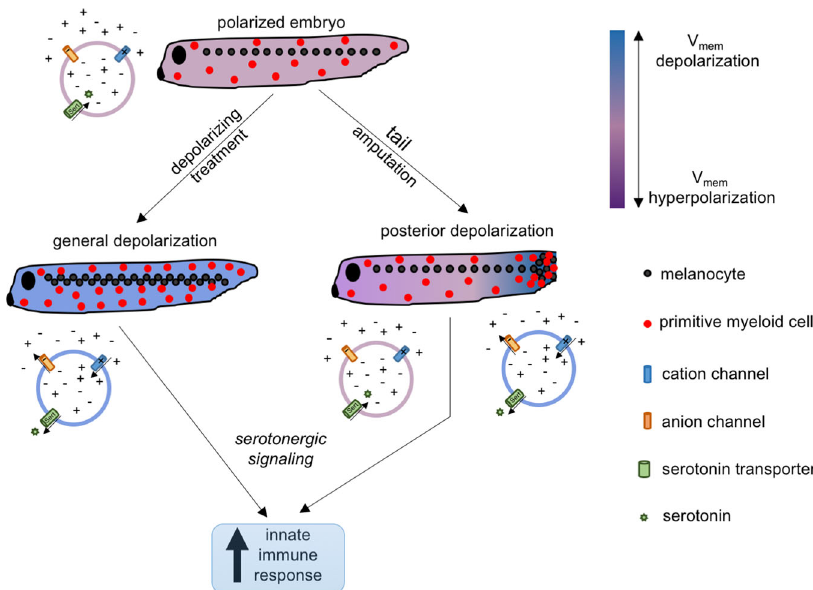
Fig. 7 Model integrating V mem signal into innate immune response. Unperturbed tadpoles harbor polarized cells, with speci fi c native amounts and distributions of melanocytes and primitive myeloid cells. Following chemical/genetic treatments that depolarize V mem , pathways involving serotonin signaling induce proliferation and redistribution of melanocytes and primitive myeloid cells, leading to an increase in the ef fi ciency of the immune response when stimulated with a pathogenic agent. Tail amputation induces a strong posterior V mem depolarization (at the site of injury), where melanocytes and primitive myeloid cells are recruited, resulting in a net increase of the latter in the embryo, leading to an enhanced innate immune